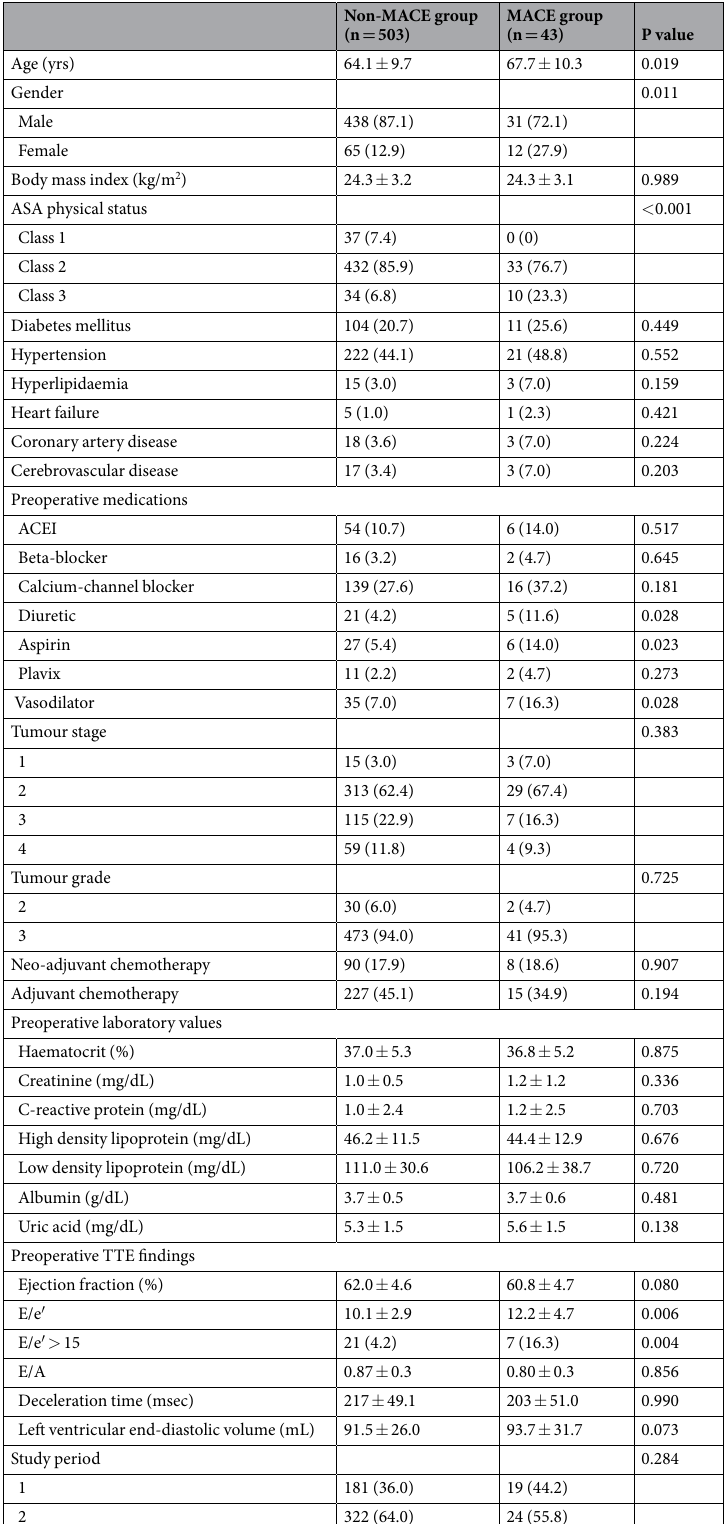
Table 1. Preoperative data of 546 patients who underwent radical cystectomy. Data are expressed as mean ± standard deviation or number of patients (%). MACE = major adverse cardiac events; ASA = American Society of Anesthesiologist; ACEI = angiotensin-converting enzyme inhibitor; TTE = transthoracic echocardiography; E/e ′ = early transmitral filling velocity/early diastolic septal mitral annulus velocity, E/A = early transmitral filling velocity/late transmitral filling velocity. Years 2005 to 2010 were classified as period 1 and years 2011 to 2016 were classified as period